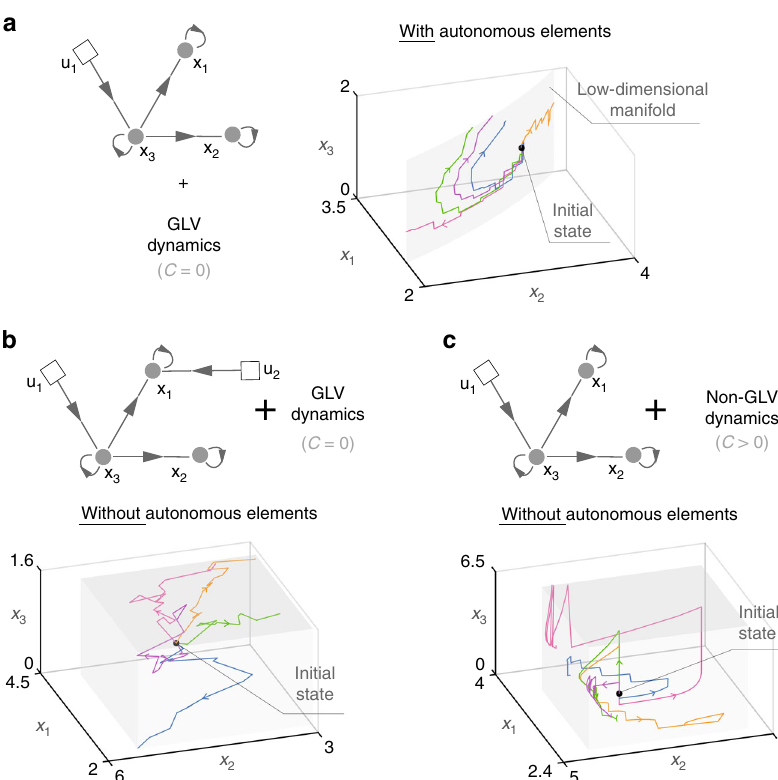
Fig. 2 Autonomous elements constrain the state of microbial communities, characterizing their driver species. a A three-species community with GLV x x x dynamics _ x 1 þ x , _ x 1 (cid:4) x , _ x 0 : 5 þ 1 : 5 x . For actuating x 3 , we consider the impulsive control scheme with x 3 ( t + ) = x 3 ( t ) + u 1 ( t 1 ¼ 1 ð(cid:4) 3 Þ 2 ¼ 2 ð 3 Þ 3 ¼ 3 ð(cid:4) 3 Þ